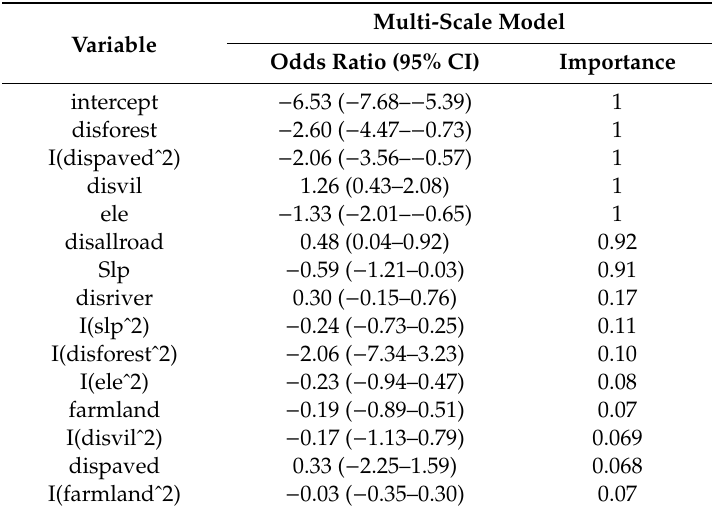
Table 3. Model-averaged interquartile range odds ratios, 95% confidence intervals, and variable importance for the top multi-scale mode.